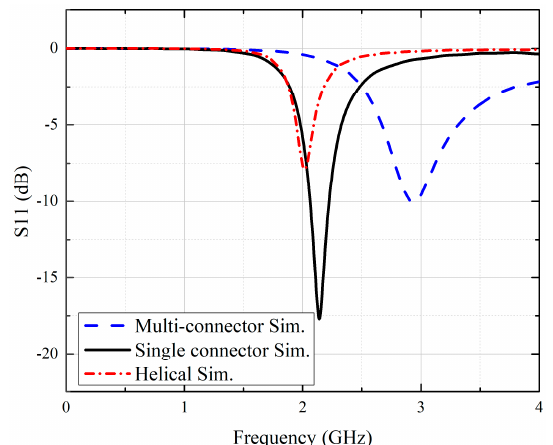
Figure 6. Simulated reflection coefficients of the helical stent, multi-connector stent, and single-connector stent antennas.